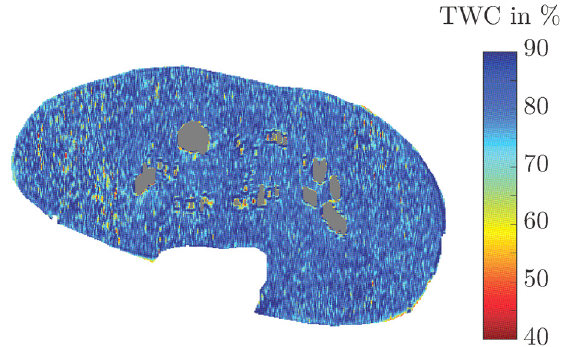
Figure 9. TWC distribution map of a kidney during NMP.